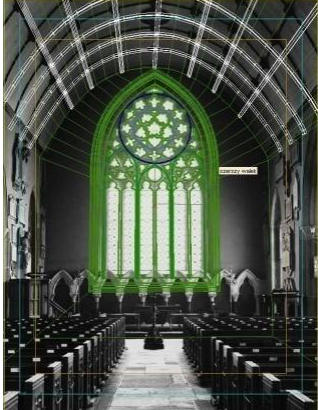
Figure 12 Historical images are the basis for 3D reconstruction of the church.